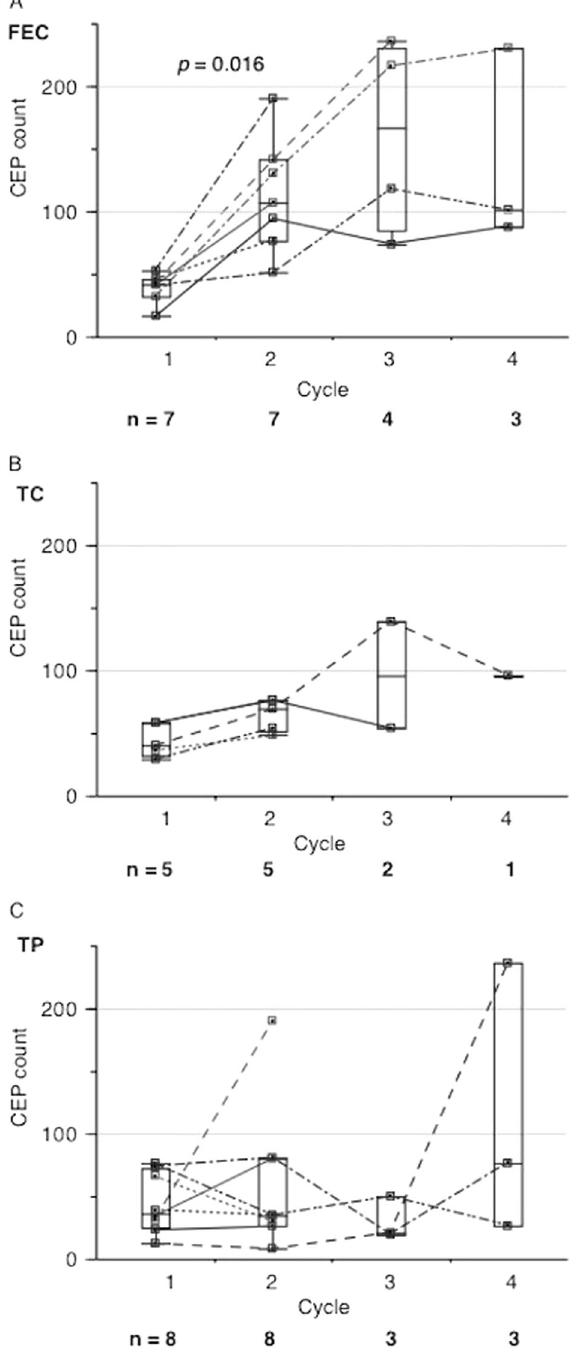
Fig. 3 Alteration in CEP counts during neoadjuvant chemotherapy with respect to regimen (A: FEC, B: TC, C: TP). The y-axis indicates CEP counts. In patients receiving the anthracycline-based regimen, the number of CEPs increased from pre-1st to pre-2nd cycle of chemotherapy ( p = 0.016, Wilcoxon signed-rank test :